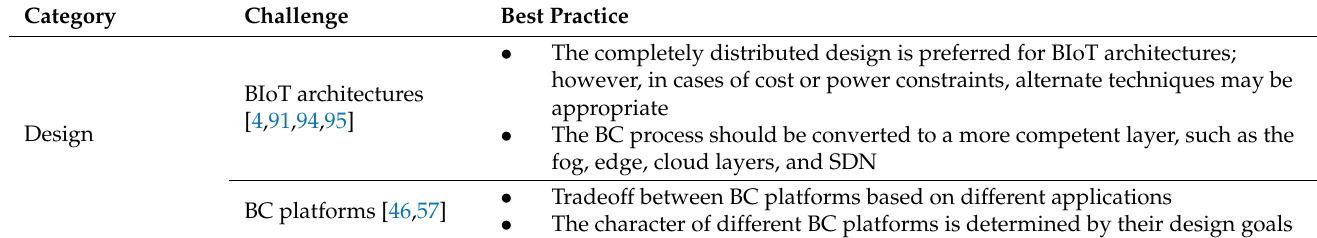
Table 12. Recommendations for reducing the negative impact of design